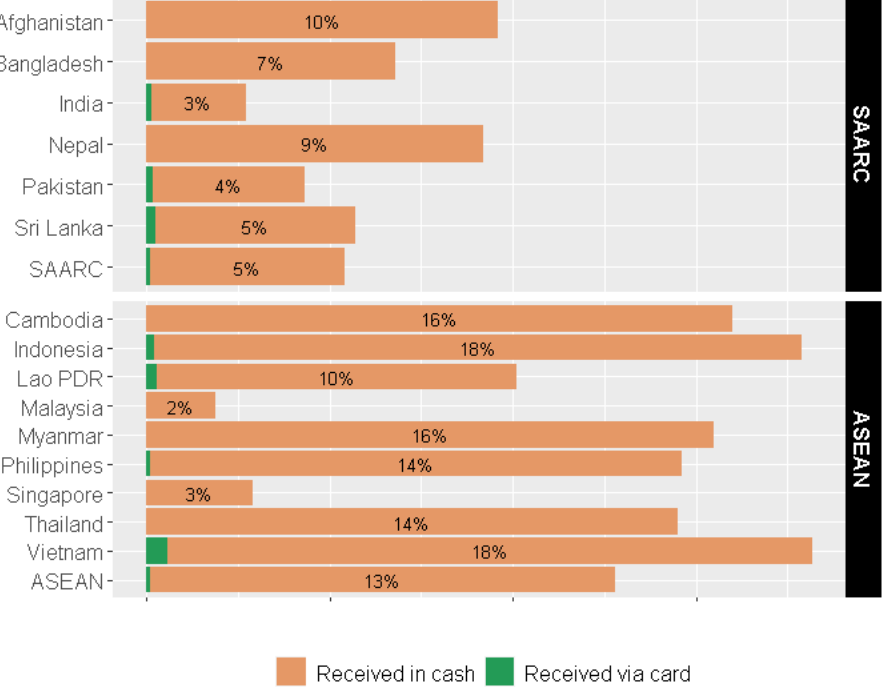
Figure 15. Percentage of participants who received money from self ‐ employment activities in cash, and via cards.